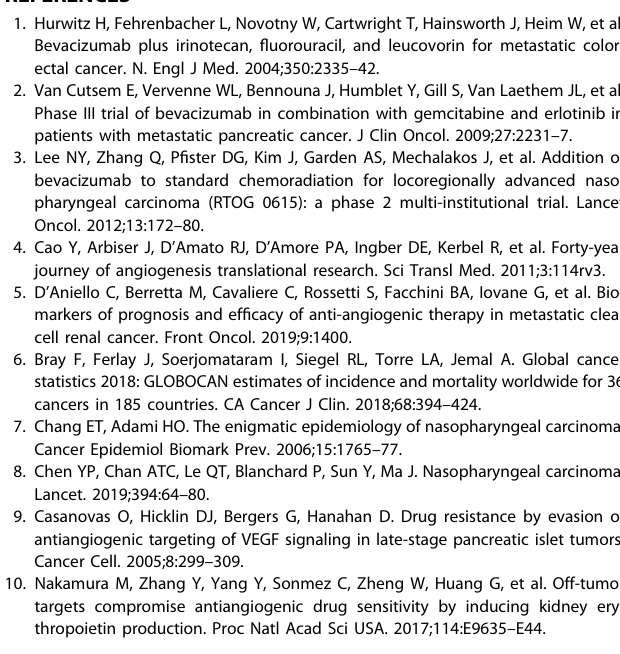
Fig. 8 Schematic diagram of FGF-2-FGFR1-ERK-MYC axis mediates AAD resistance and metastasis in NPC. NPC cancer cells often produce FGF-2, and FGF-2 impedes the AAD-mediated anti-EC effect in the TME. In FGF-2 positive tumors, the FGFR1-ERK-MYC axis is upregulated in ECs and compensates for VEGF-VEGFR2-MYC signaling. MYC further drives downstream angiogenic genes, hence keep the angiogenesis in the TME. Angiogenic tumor vessels further facilitate tumor cell intravasation and pulmonary metastasis. In such FGF-2 high TME, inhibition of VEGF-VEGFR2 signaling alone does not effectively inhibit angiogenesis. Lenvatinib, an FDA-approved multi- kinase inhibitor targeting both VEGFR2 and FGFR1, exhibits robust antiangiogenic and anti-tumor effects in NPC or possibly FGF-2-rich